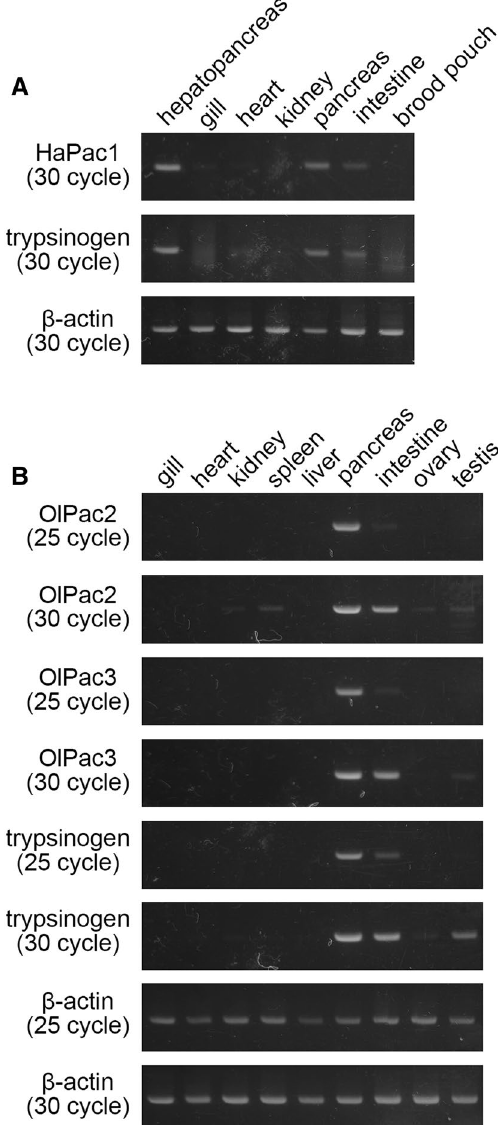
Figure 4. Semi-quantitative expression analysis of pactacin and trypsinogen genes. ( A ) HaPac1 and trypsinogen gene expression in adult seahorse hepatopancreas, gills, heart, kidney, mesentery including pancreas (labeled as pancreas), intestines, and brood pouch. ( B ) OlPac2 (MC6AST2), OlPac3 (MC6AST3), and trypsinogen gene expression in adult medaka gills, heart, kidney, spleen, liver, mesentery including pancreas (labeled as pancreas), intestines, ovary and testes. β-actin was used as a control signal. Band regions are cropped, and full-length gels are included in a Supplementary